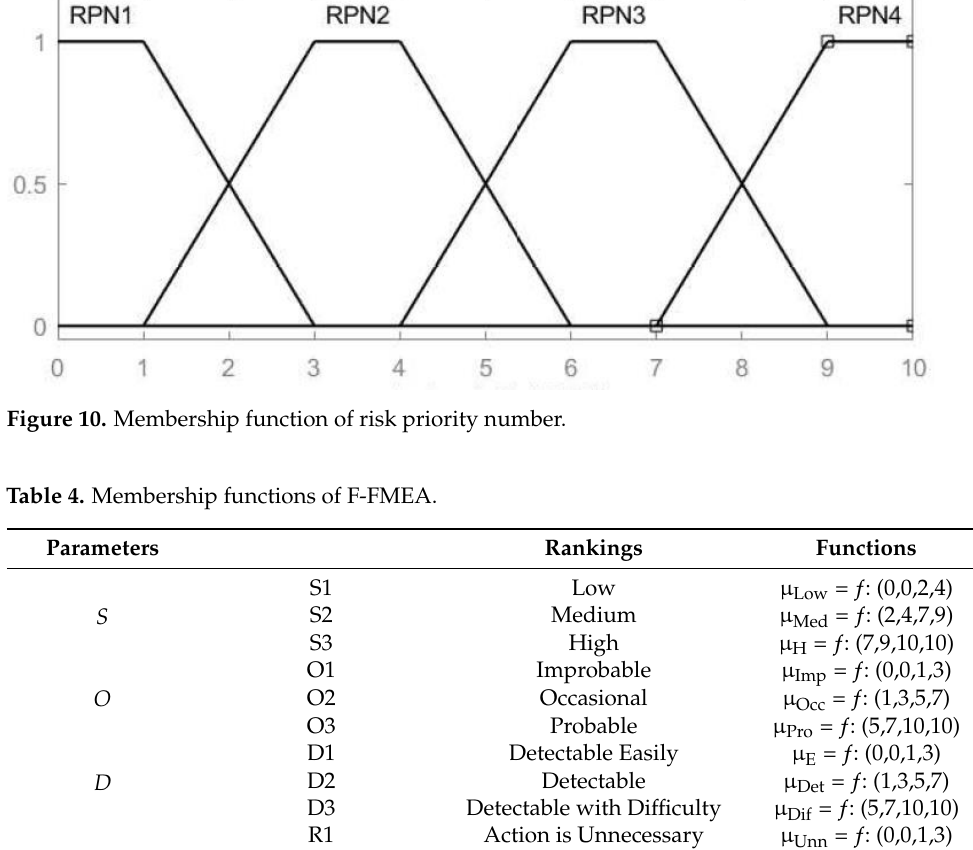
Table 5. Rule base for the composition process .